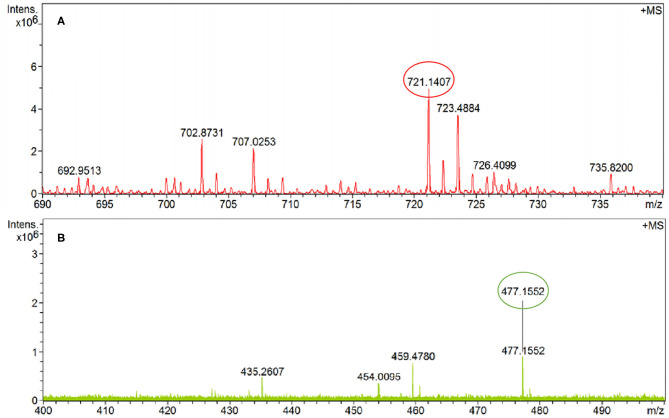
The HRMS spectra of PCN (A) and PCN–Al3+
(B).